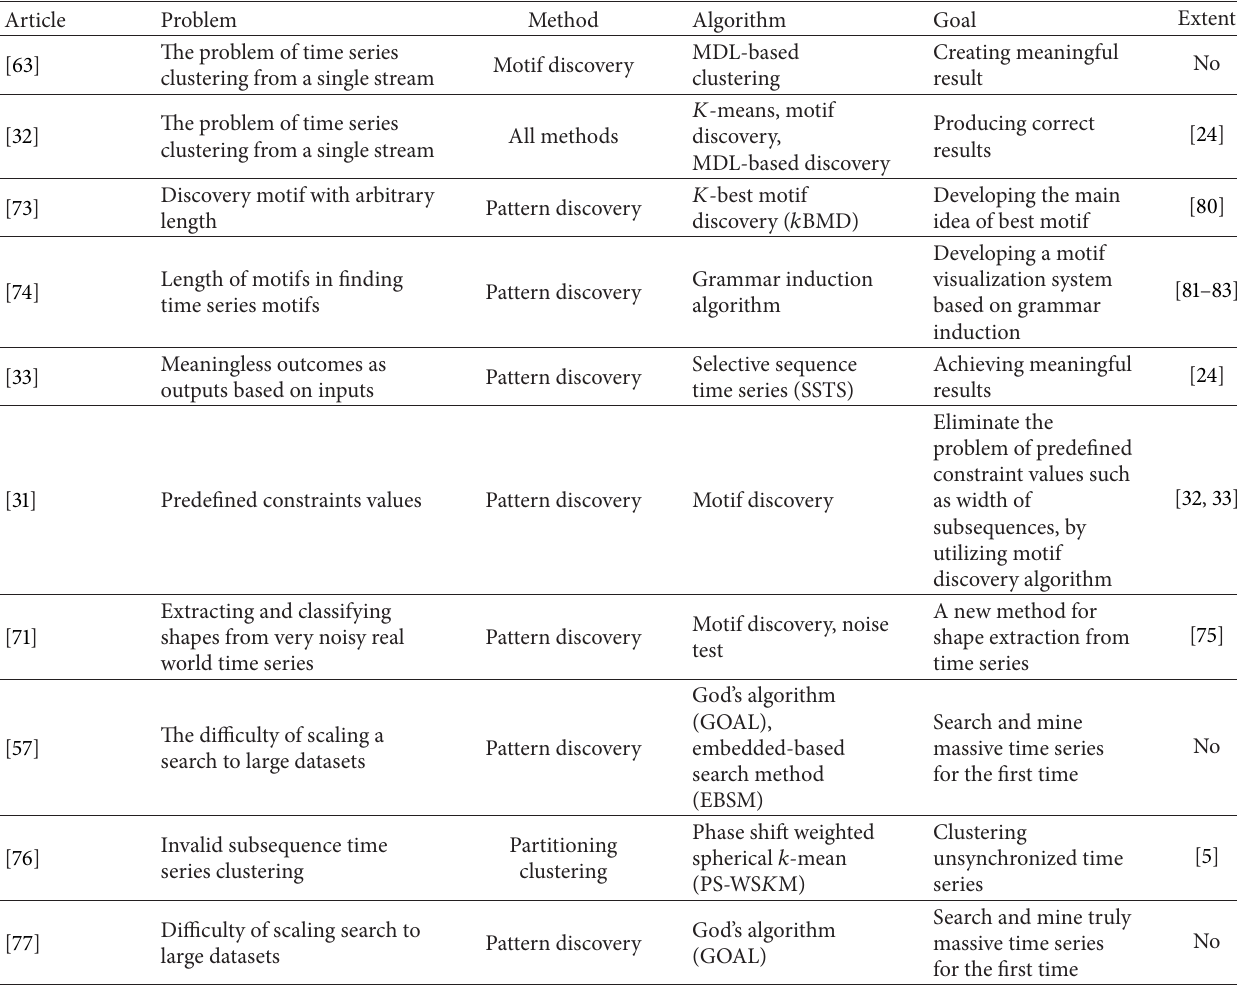
Table 3: The summary of postproof period